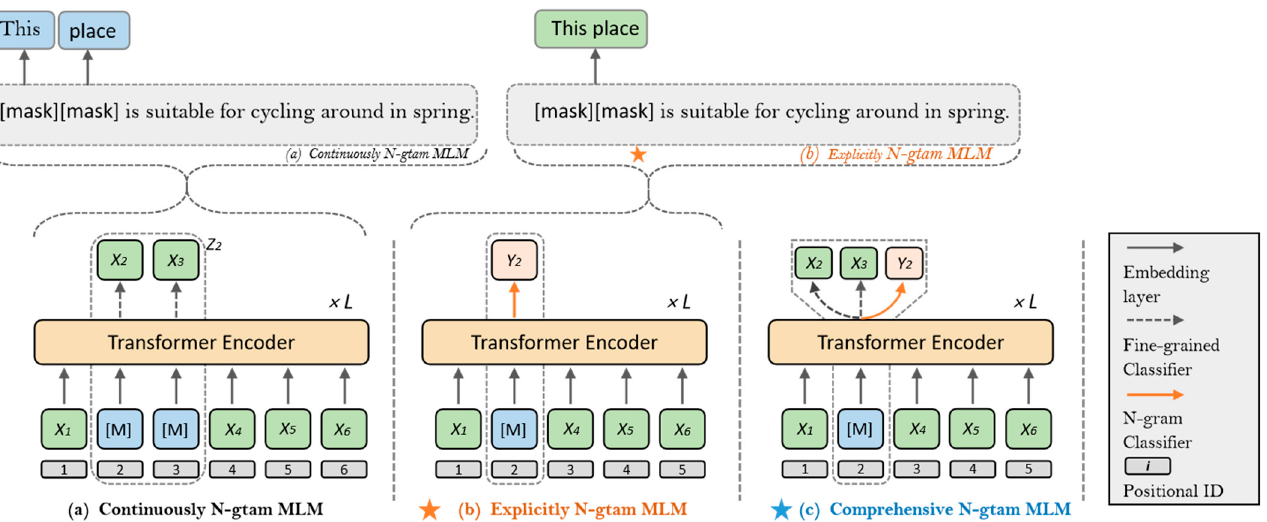
Figure 2. Framework diagram of transformer-encode.